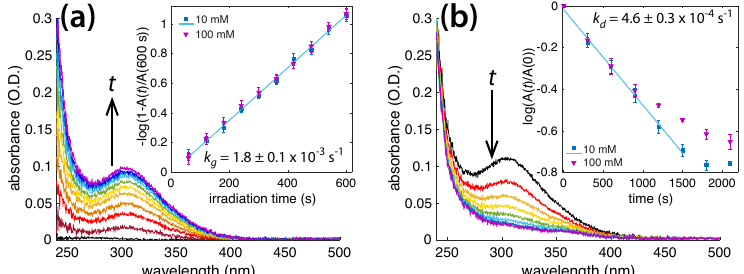
Figure 2. ( a ) Absorbance spectra taken every 60 s during irradiation of 10 mM NH solution. Inset: 3 Equation (7) plotted for 10 and 100 mM NH solutions vs irradiation time, with linear least-squares 3 fit; ( b ) Absorbance spectra taken every 300 s following termination of initial 600 s laser irradiation of 10 mM NH solution. Inset: Equation (8) plotted for 10 and 100 mM NH with linear least-squares 3 3